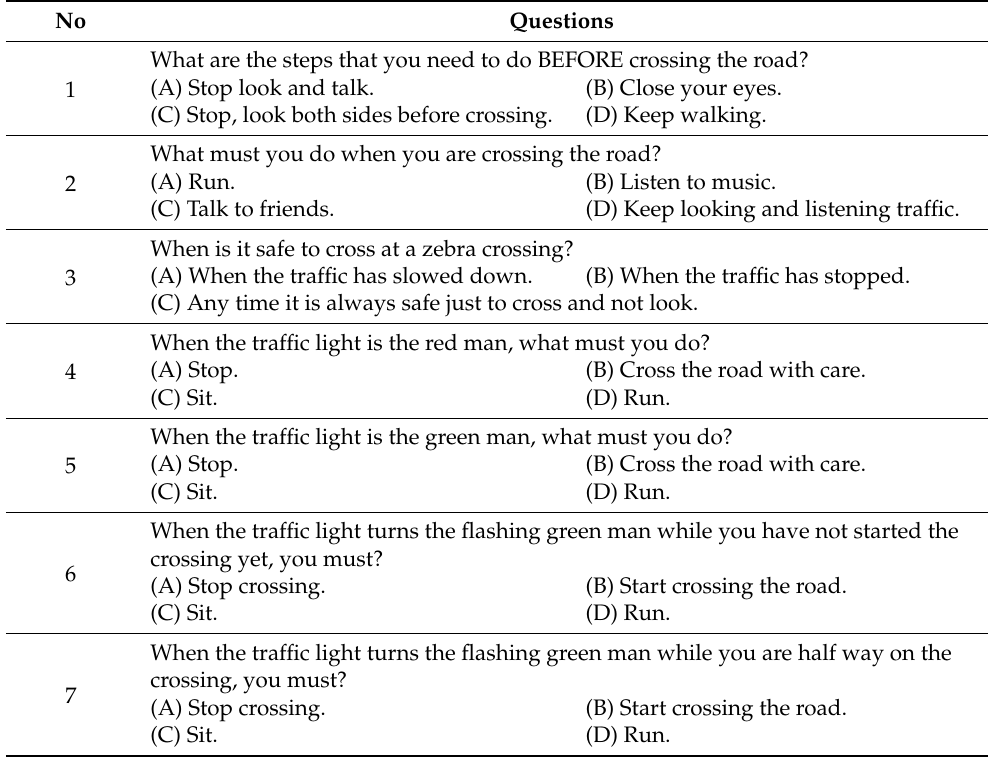
Table 1. Example quiz questions for participants.